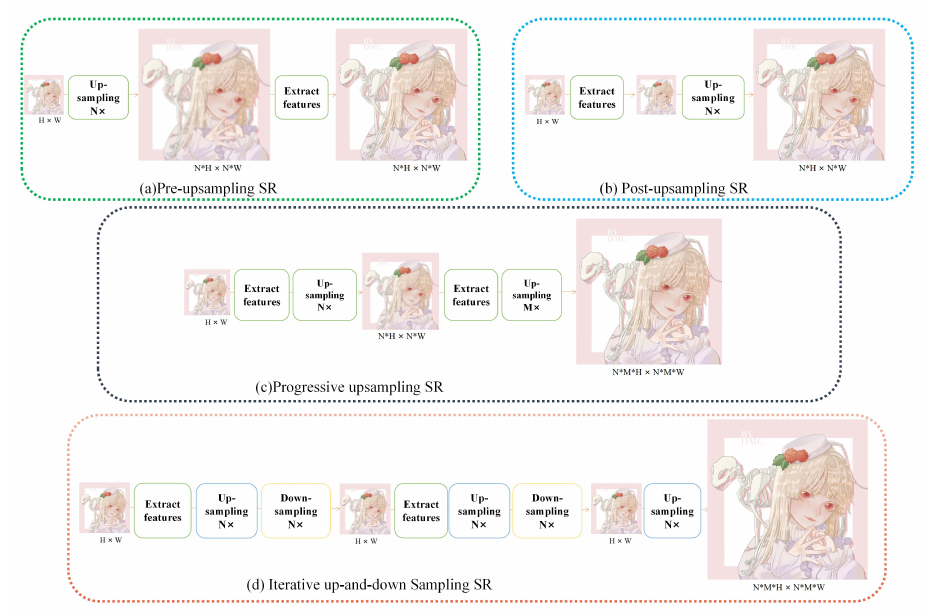
Figure 2. The network structure of super-resolution